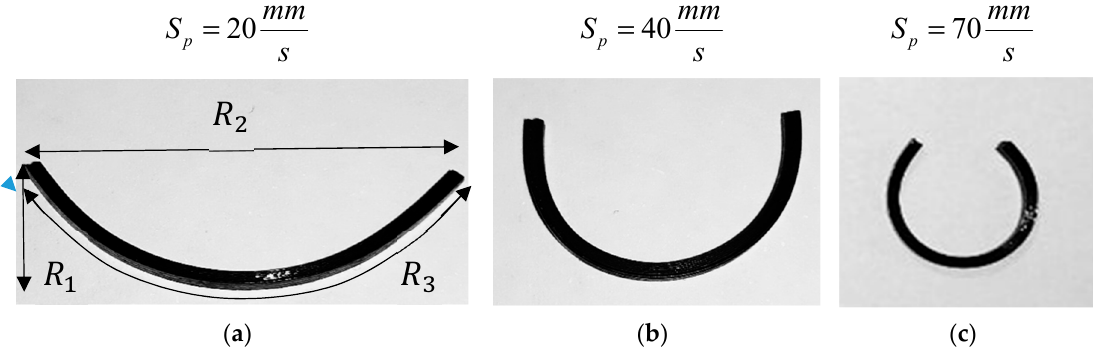
Figure 7. Deformed configurations of the beams printed with different speeds after the heating–cooling process.